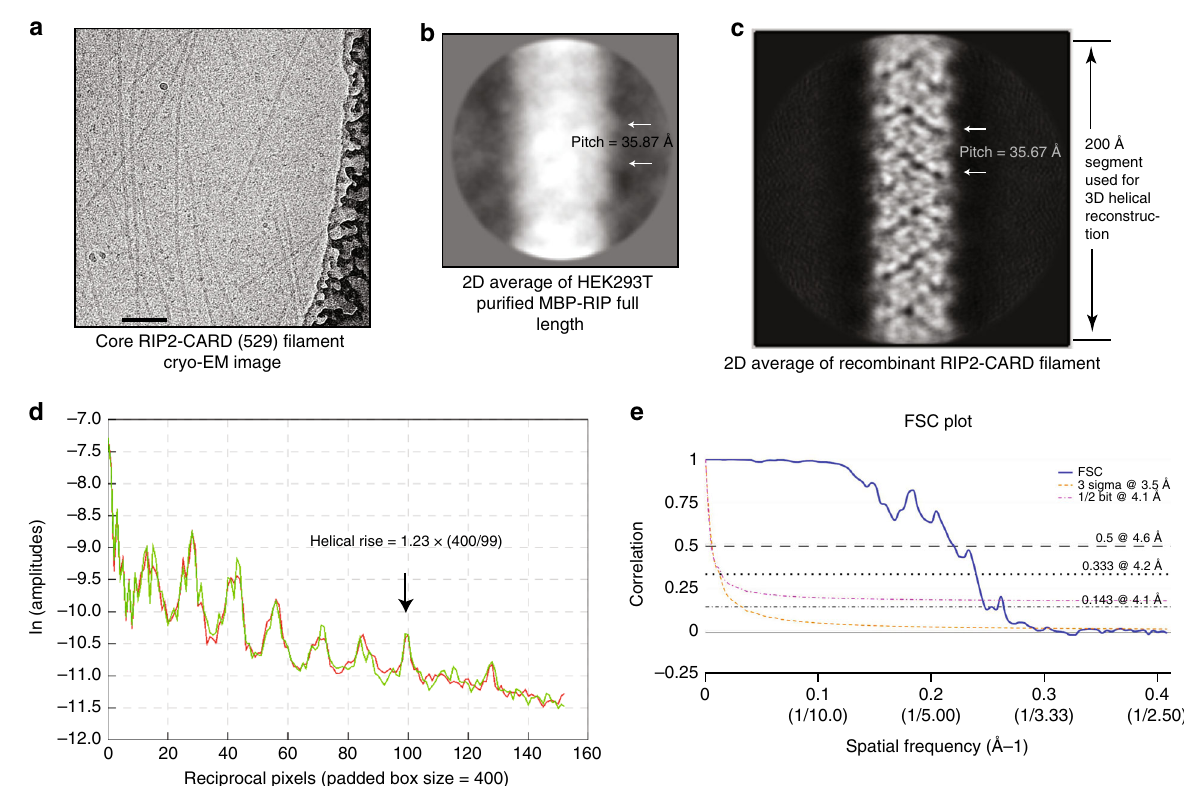
Fig. 4 Electron density of RIP2 – CARD fi lament resolved using helical reconstruction. a Cryo-EM micrograph of core RIP2 – CARD – EM construct. Scale bar: 100 nm. b Representative 2D class average of MBP – RIP2 extracted from HEK293T cells. About 500 segments were used to generate this preliminary 2D average class. By manual counting of the pixels between the two protrusions along the fi lament. Visual helical pitch was found to be about 35.87 Å. c 2D class image of the core RIP2 – CARD – EM generated when picking 140,000 segments. Visual helical pitch was found to be about 35.67 Å. d The helical layer line pro fi le from Relion analysis of the RIP2 – CARD fi lament data. The last signal peak (from left to right) indicates the position of the last (furthest) layer line, which could be used to calculate helical rise parameter. e The FSC plot showed that the resolution for the overall density of the entire segment is 4.1 Å, at FSC = 0.143 gold